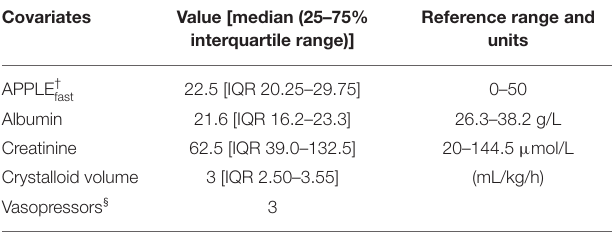
TABLE 3 | Clinical and laboratory covariates for the sick dog